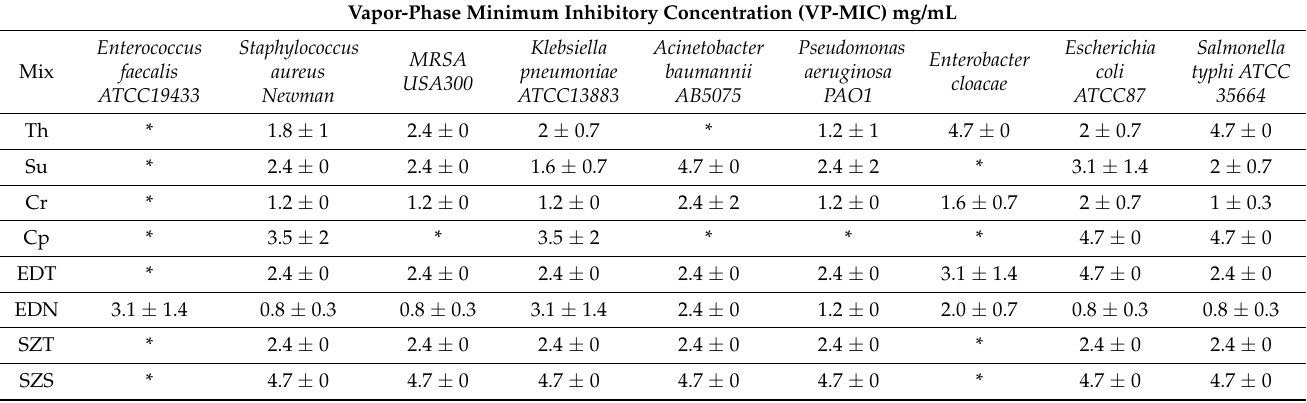
Table 3. Vapor-phase antibacterial activity of the tested herbal mixtures and their major